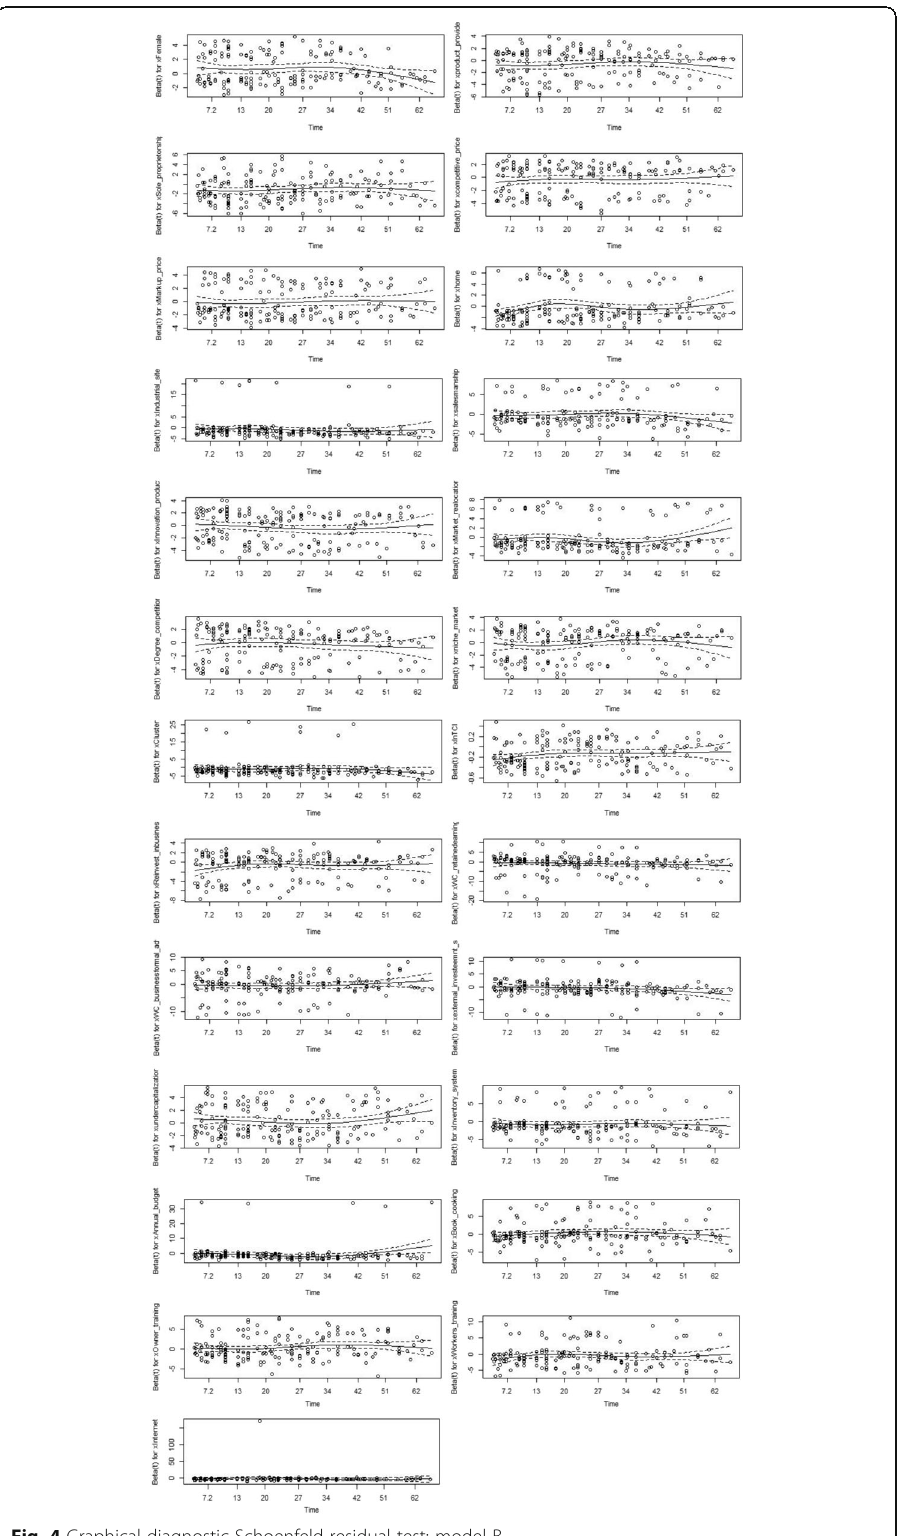
Fig. 4 Graphical diagnostic Schoenfeld residual test: model